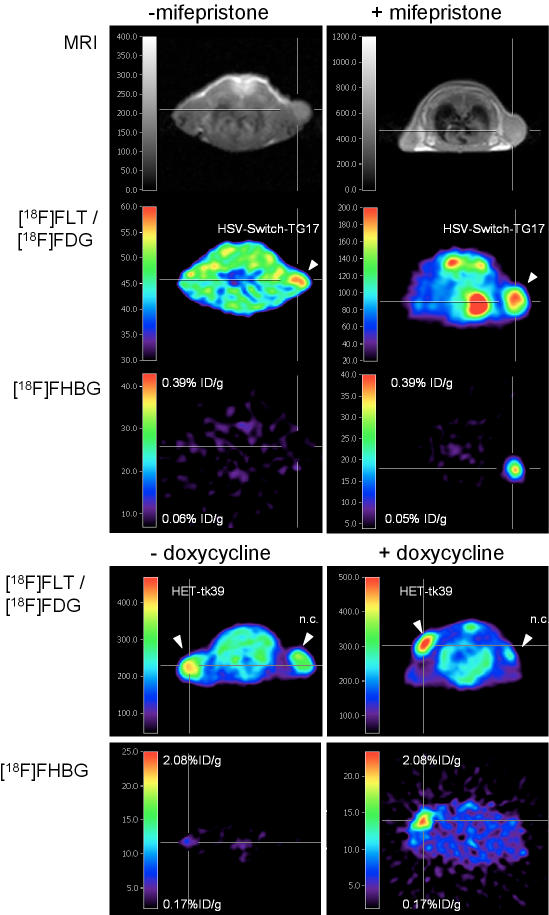

In vivo imaging of regulated gene expression.Multimodal imaging ([18F]FLT-, [18F]FDG- and [18F]FHBG-PET) of inducible gene expression by PET in nude mice bearing subcutaneous human Gli36ΔEGFR xenografts employing HSV-Switch-TG17 or HET6C-tk39. Mice were randomized to mifepristone- or doxycycline-treated (each group n = 7) and untreated (n-mif = 8; n-dox = 12) groups. Indicated xenografts (arrowhead) were injected with HSV-Switch-TG17 and HET6C-tk39 respectively (>2×106 t.u.) 48h prior to PET-imaging, resulting in high accumulation of [18F]FHBG in HSV-Switch-TG17 or HET6C-tk39 infected and mifepristone- or doxycycline-treated tumors as compared to some background activity in non-treated tumors.